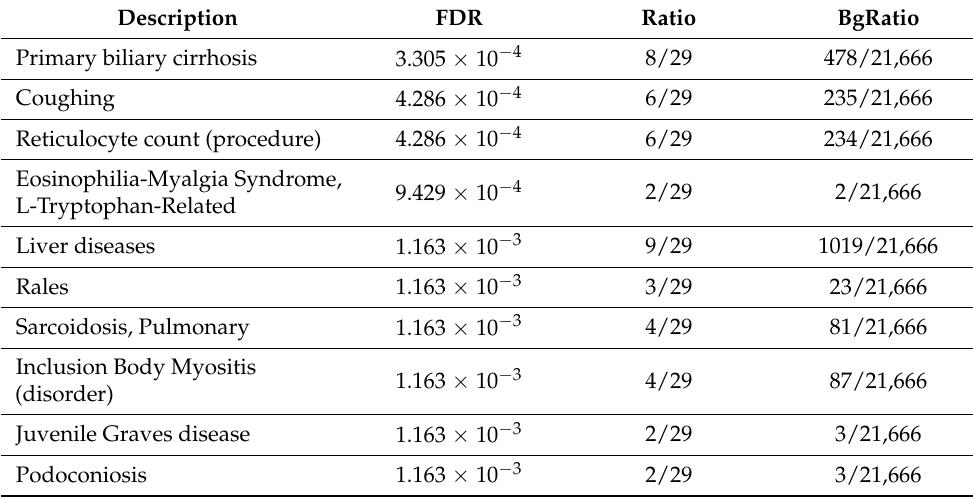
Table 3. Enrichment analysis of the genes associated with COVID-19, obtained in disgenet2r (R package) . The ratio column represents the number of genes from the input list that are associated with the disease. The BgRatio are the number of genes associated with the disease from the length of the universe, in the example, all genes in DisGeNET (the curated or background genes). The p -values resulting from the multiple Fisher tests are corrected for the false discovery rate (FDR) using the Benjamini–Hochberg (BH)